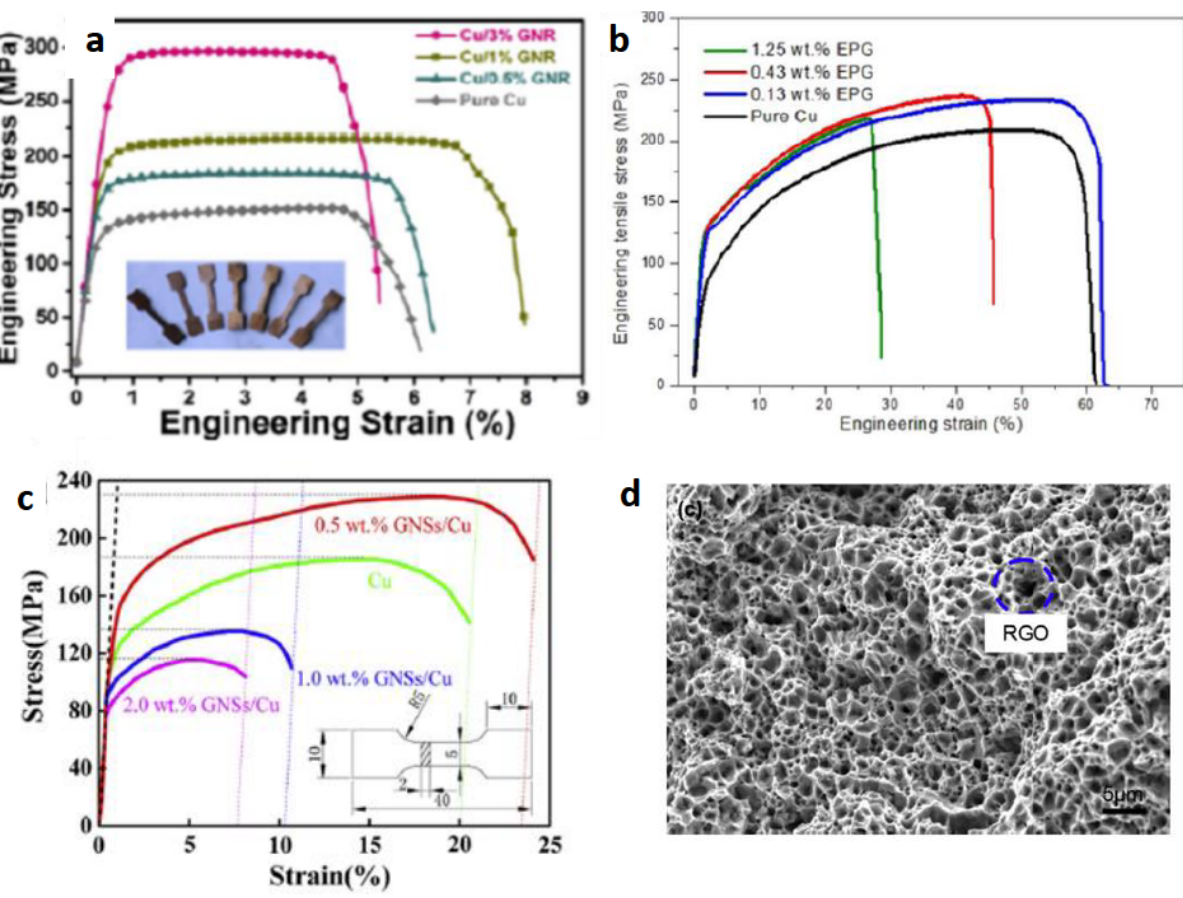
Figure 22: Tensile engineering stress-strain curves for (a) GNR-, (b) GNP-, and (c) GNS-reinforced Cu matrix composites. (d) SEM of fracture surfaces of 0.1 vol% RGO/Cu composites. Reproduced from Reference [52].